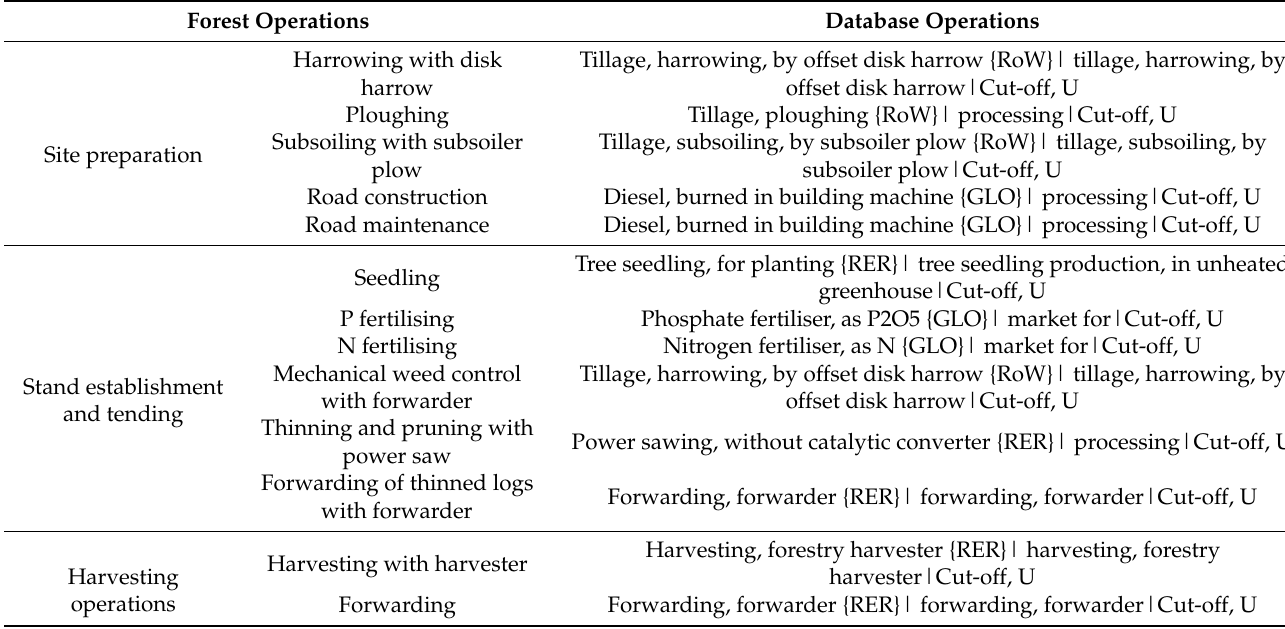
Table 2. Ecoinvent process used to model operations of various forest management scenarios within the system boundary (RoW—Rest of the World; RER—European region, GLO—Global, U—unitary process).